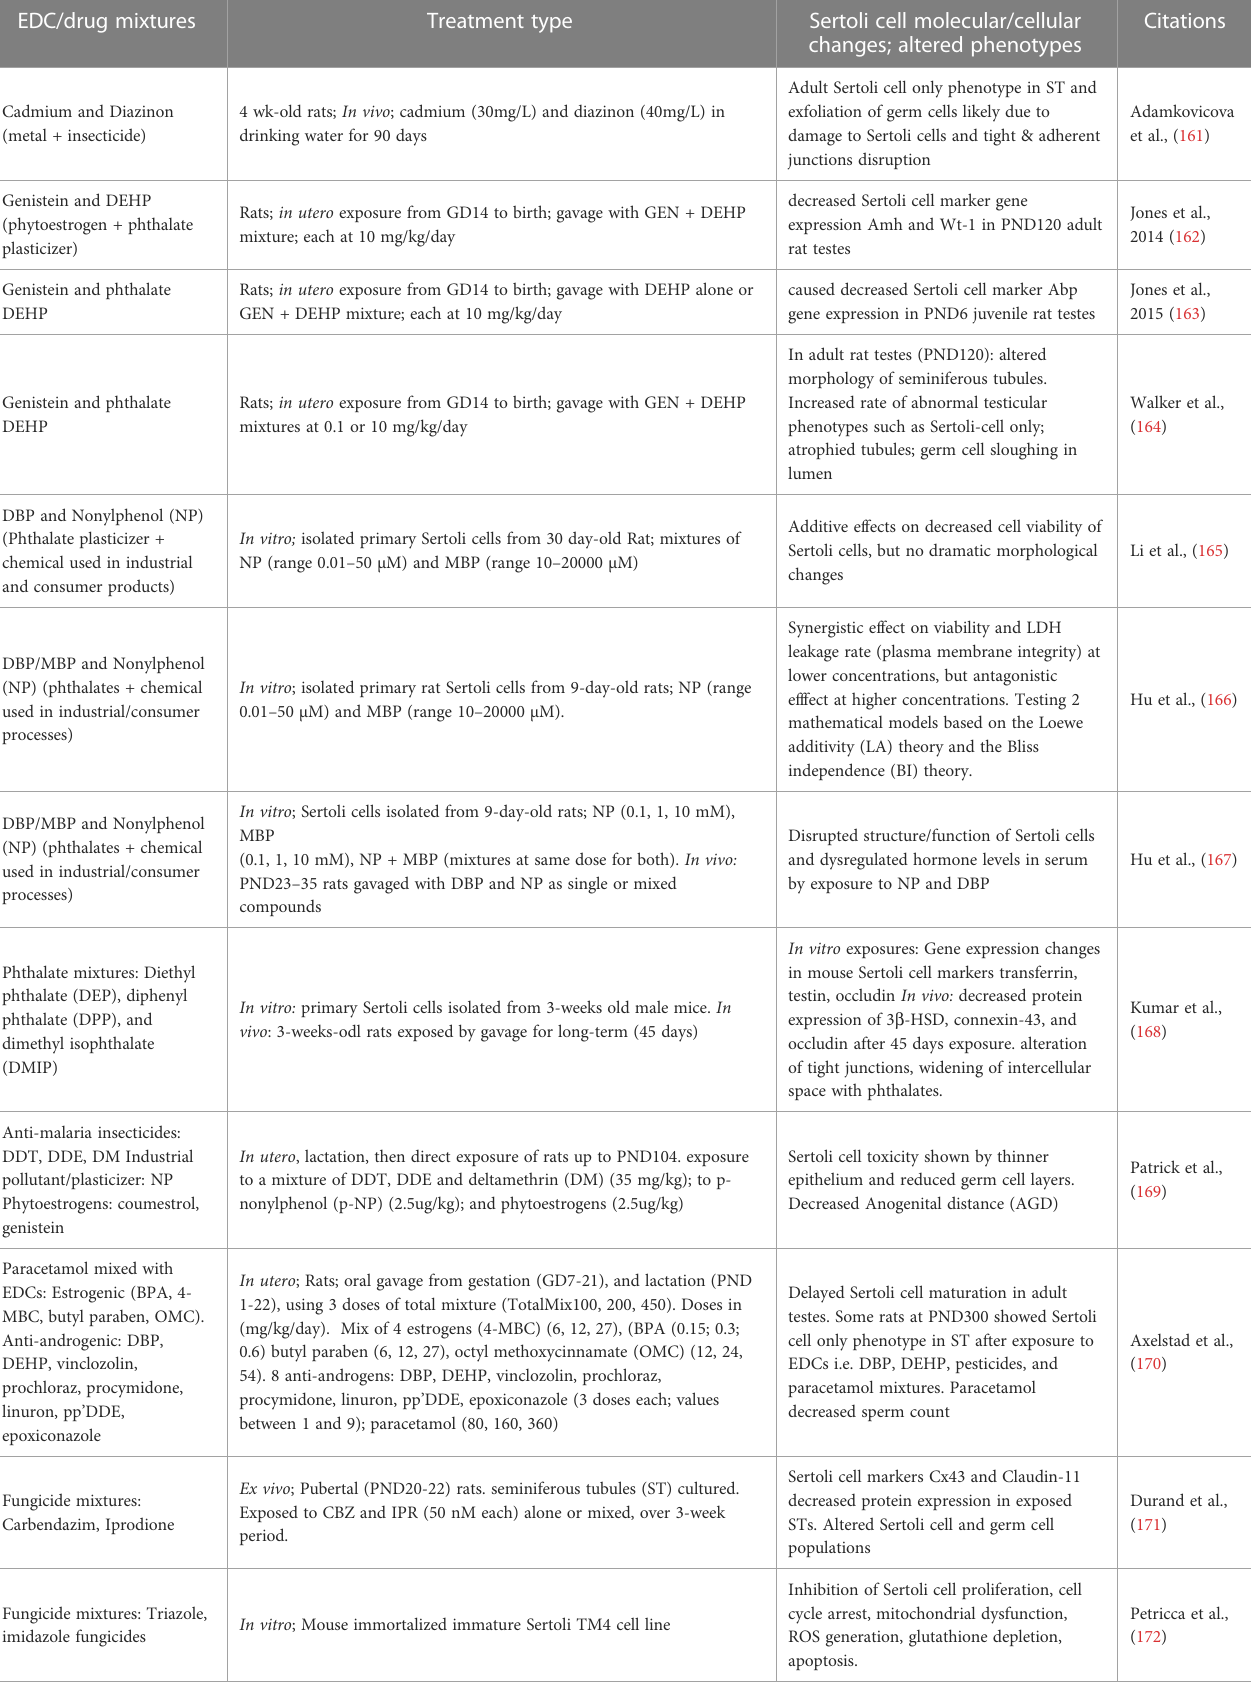
TABLE 1 Types of EDC and EDC-drugs mixtures reported to affect Sertoli